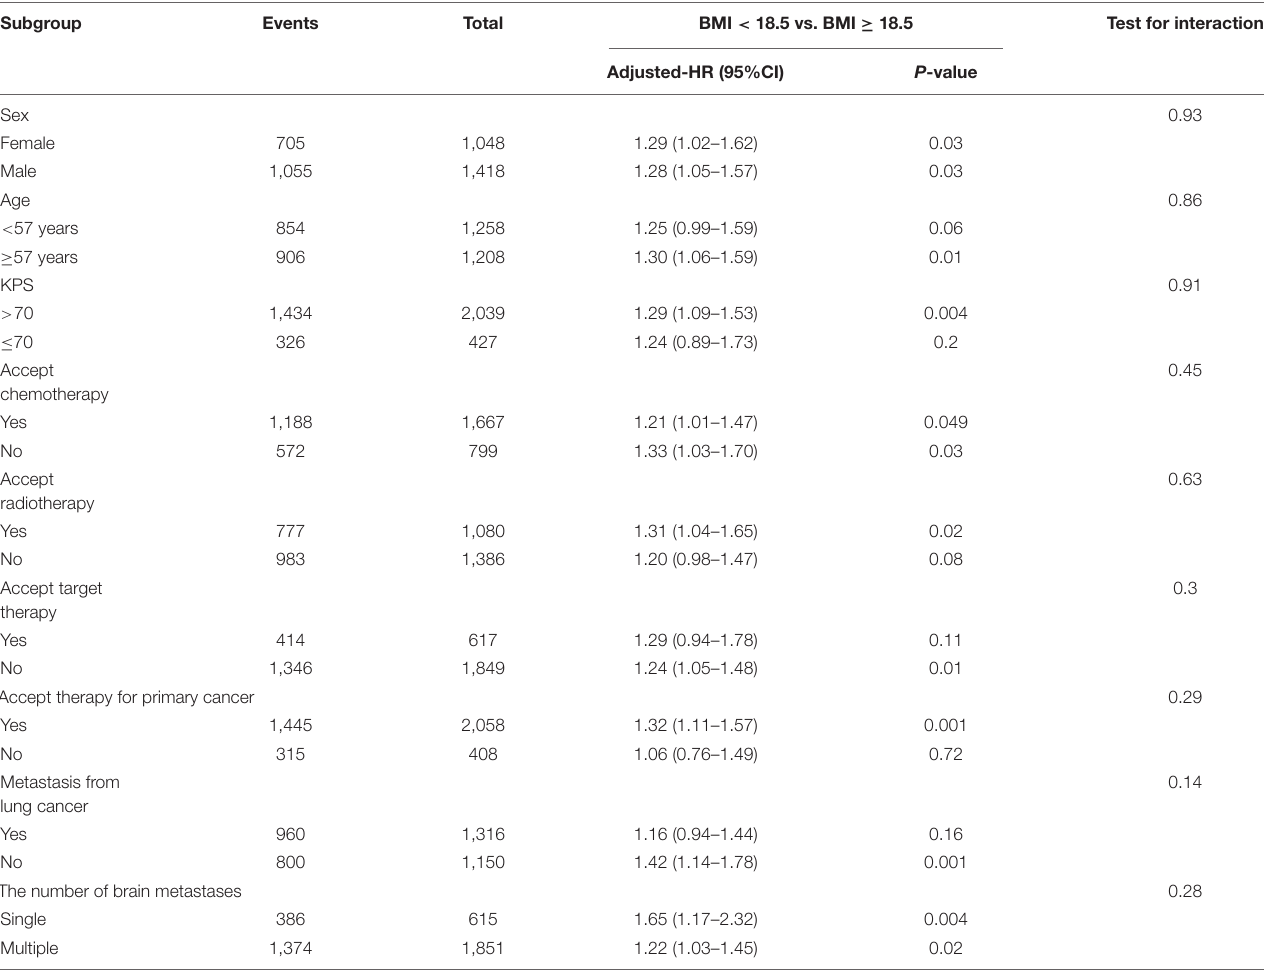
TABLE 2 | Subgroup